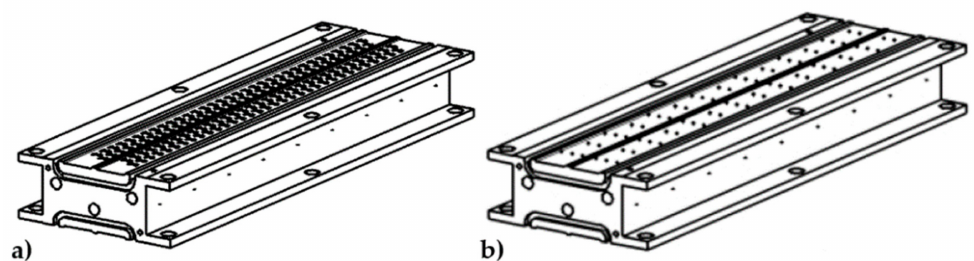
Figure 5. Aluminum half shells with passive inserts. ( a ): Contour of flat tube within aluminum shell with passive inserts used in automotive industry (reproduced with permission from [16], published by Elsevier 2021). ( b ): Contour of flat tube within aluminum shell with cylindrical pins with d = 0.6 mm.